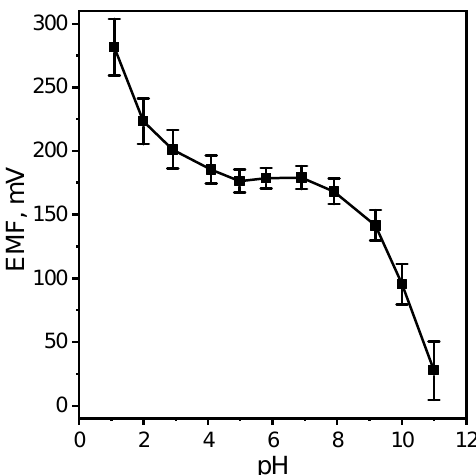
Figure 6. Effect of pH of test solution on the potential response of the